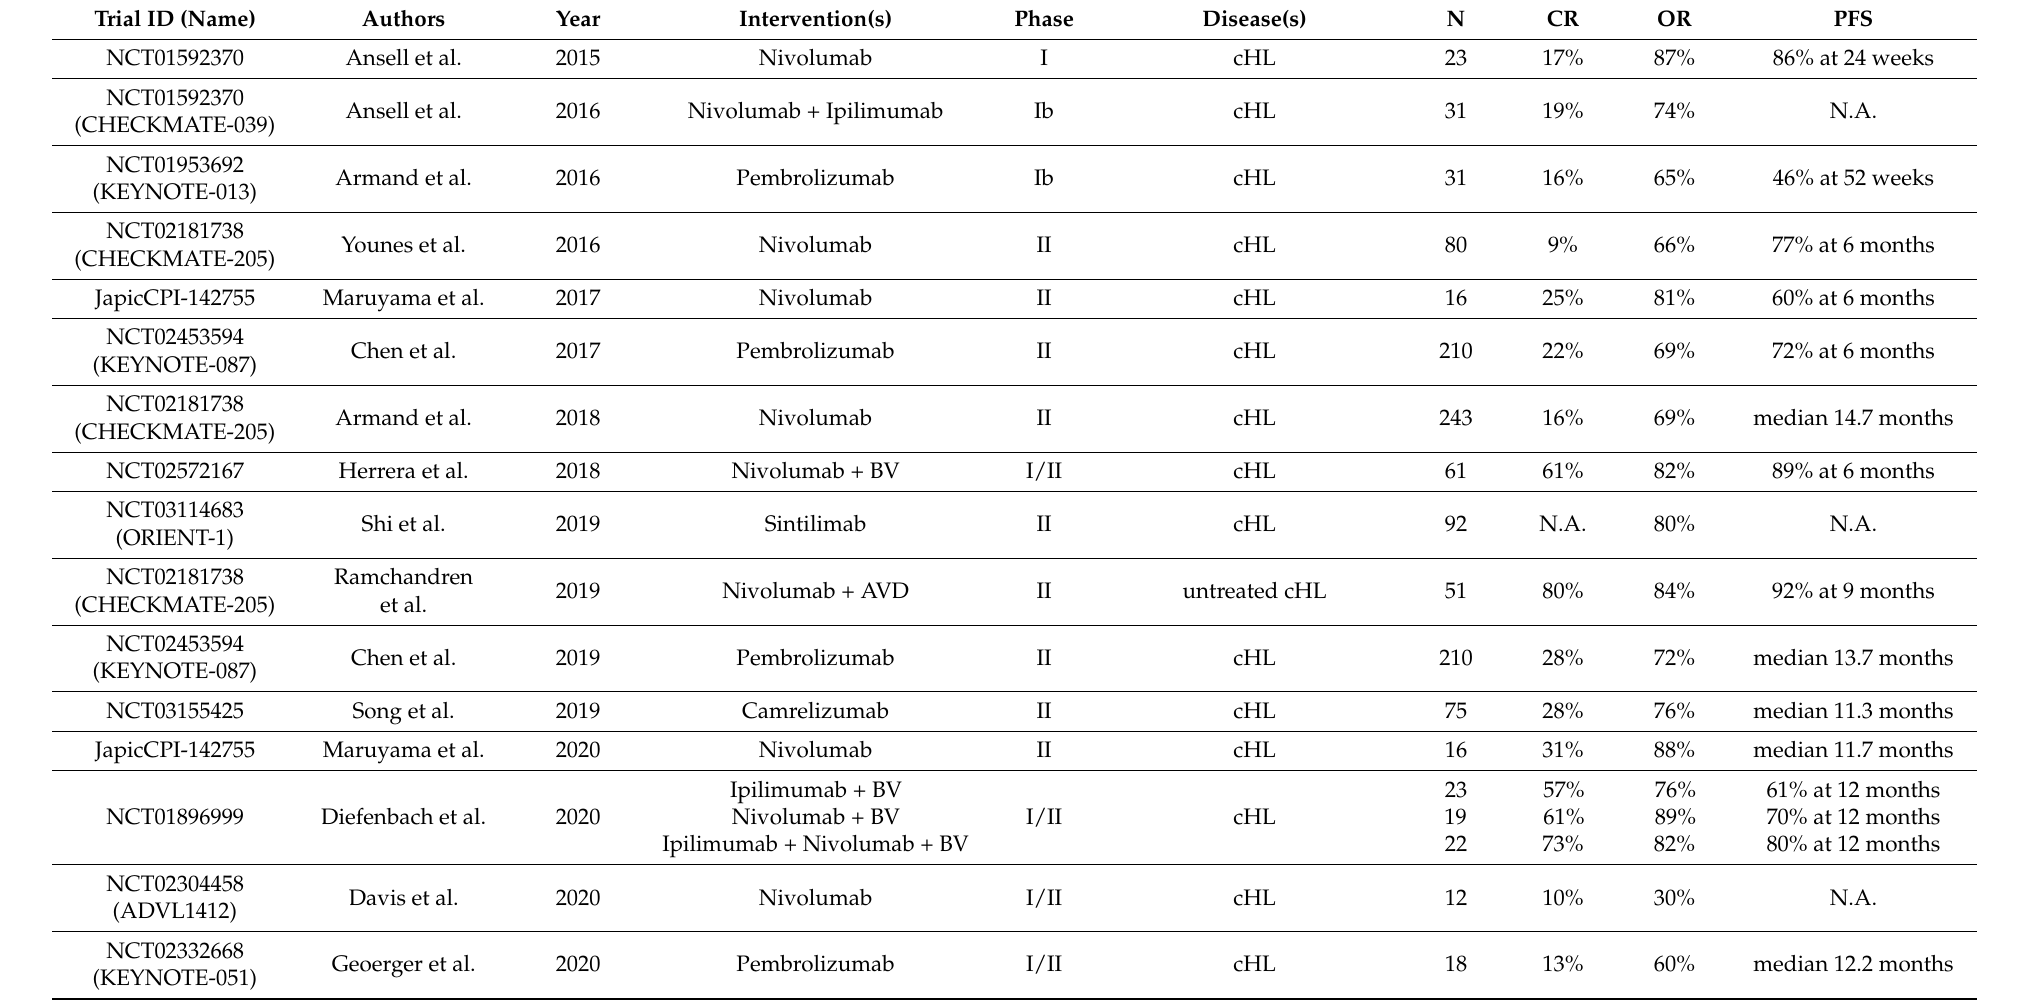
Table 2. Clinical trials of immune checkpoint inhibitors in Hodgkin